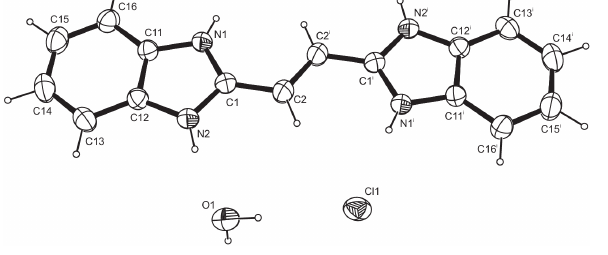
Table 1: Data collection and handling.